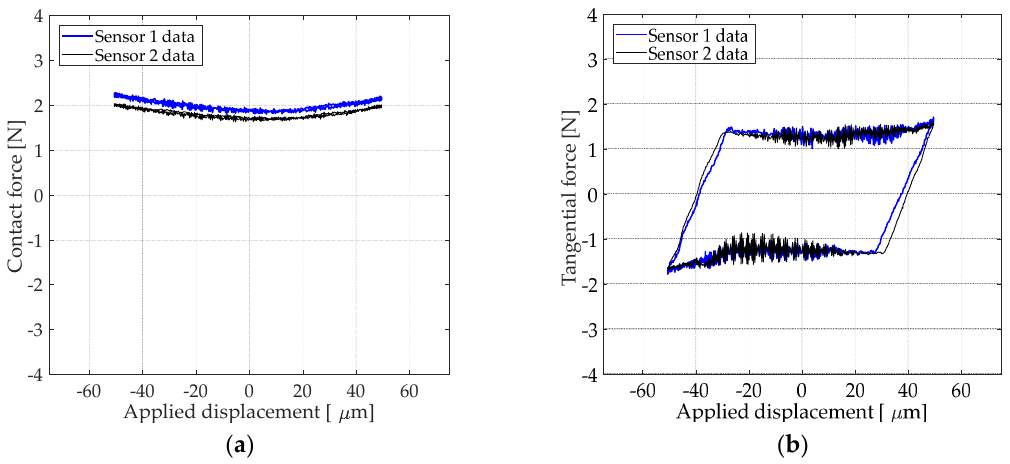
Figure 8. Evolution of the contact force ( a ) and tangential force ( b ) along a fretting cycle. Note: unfiltered data.